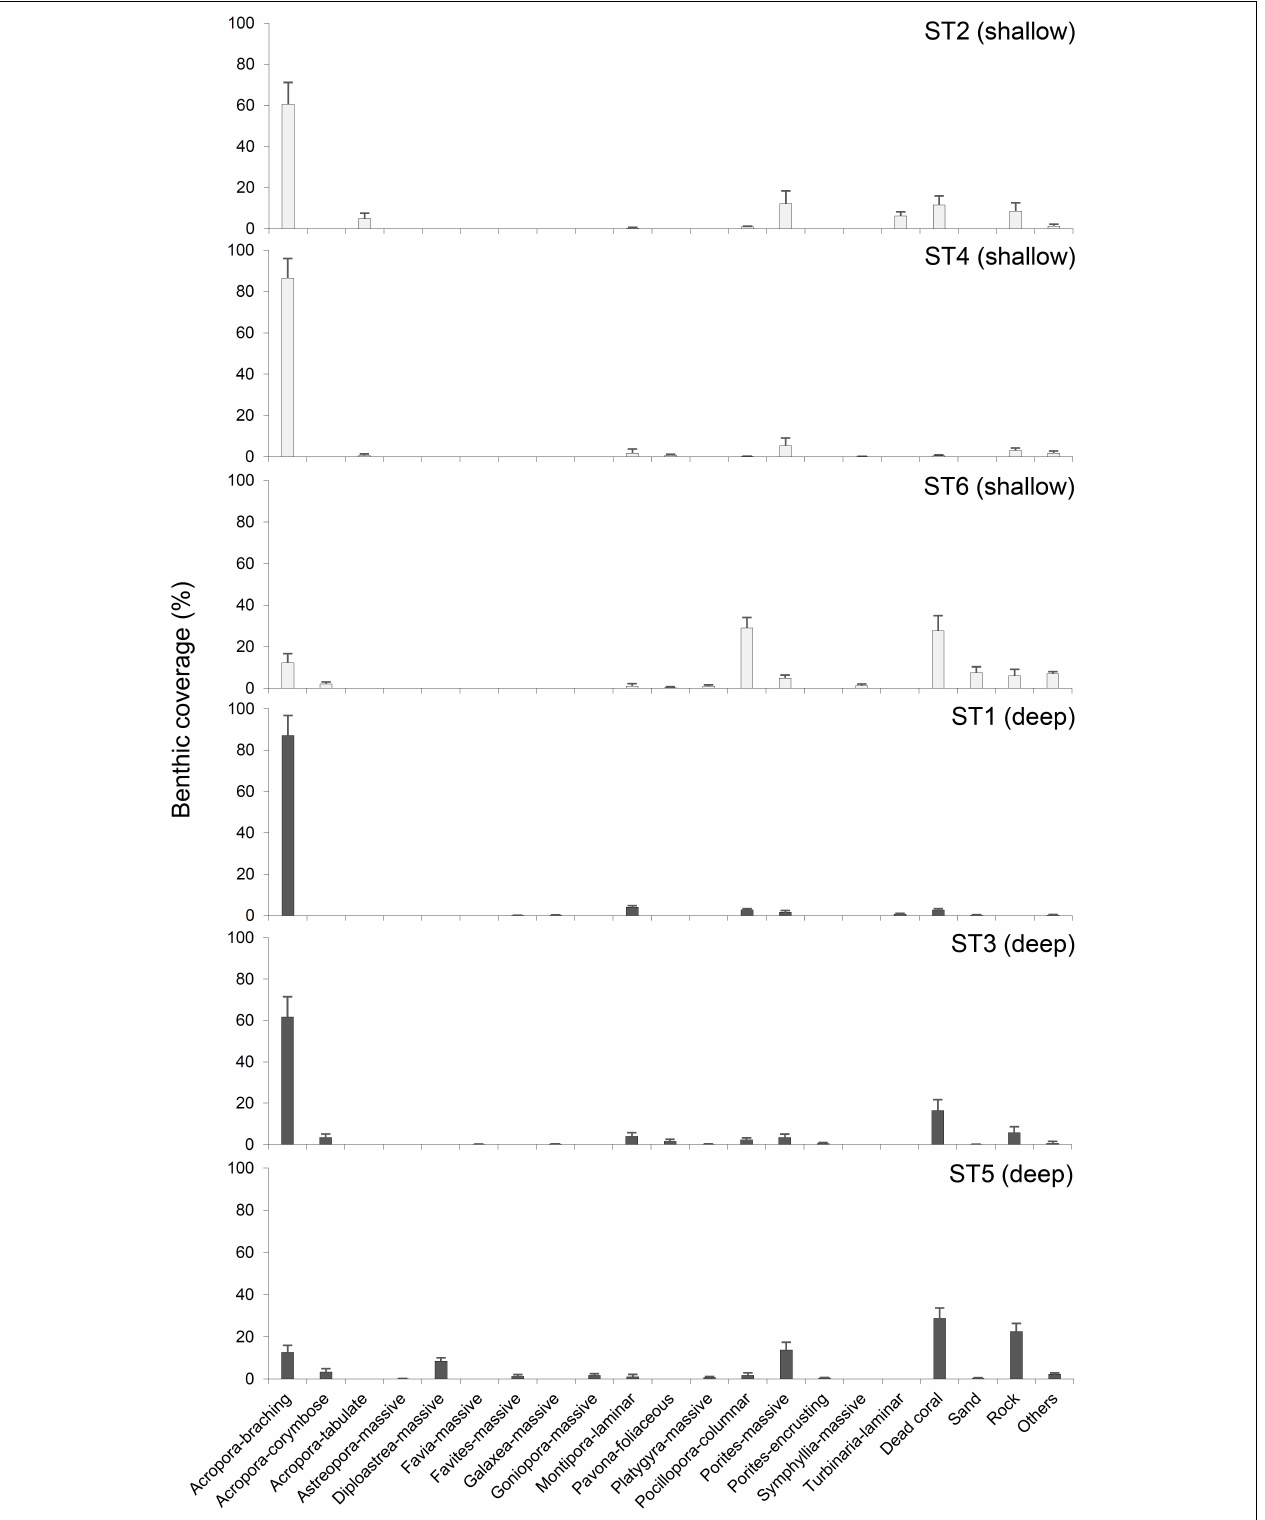
FIGURE 2 | Benthic cover data (mean + SD) observed from three shallow (10 m) and three deep (20 m) stations around Losin Pinnacle during August 2017. Percentage cover was calculated from photographs taken every half meter with three replicates at 30-m belt transects. Corals were divided into growth forms, and several abiotic variables were measured. Others represent benthic organisms other than hard